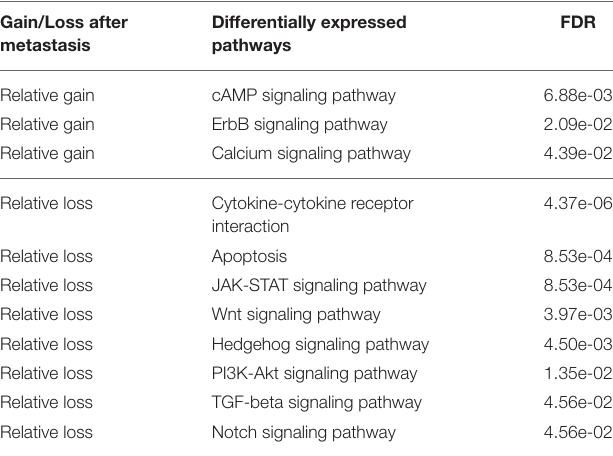
TABLE 2 | Differentially expressed cancer pathways between primary and metastatic samples (FDR <